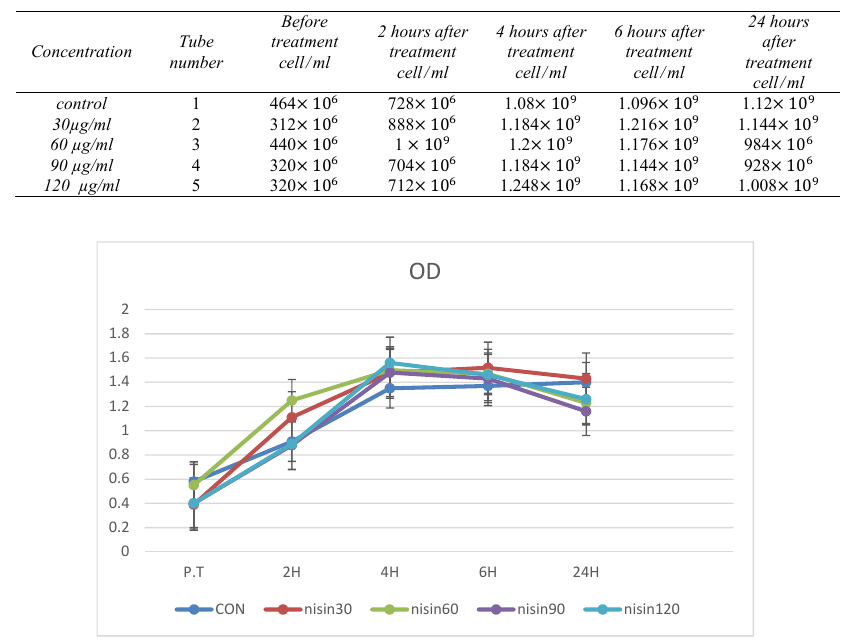
Table 6: Mean optical density reflecting antimicrobial activity exhibited by nisin-conjugated CuO NPs Concentration